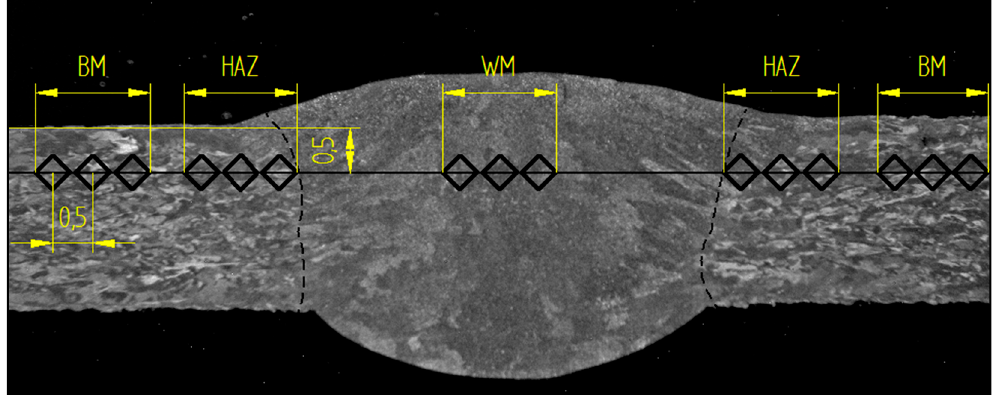
Figure 4. Hardness measurement methodology.